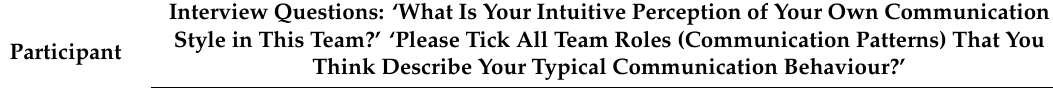
Table 4. Team role changes in Team 2 over the academic